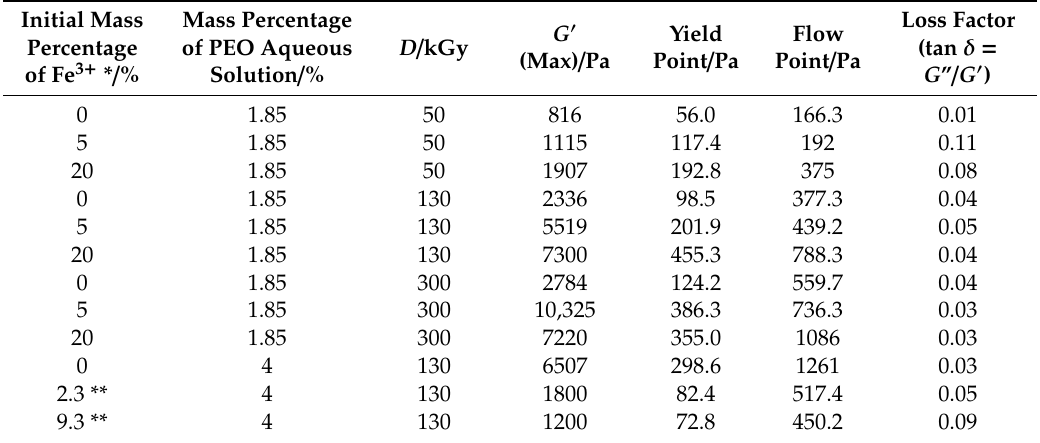
Table 2. Results of amplitude sweep test of pure PEO gels and PEO / Fe-oxide nanocomposite